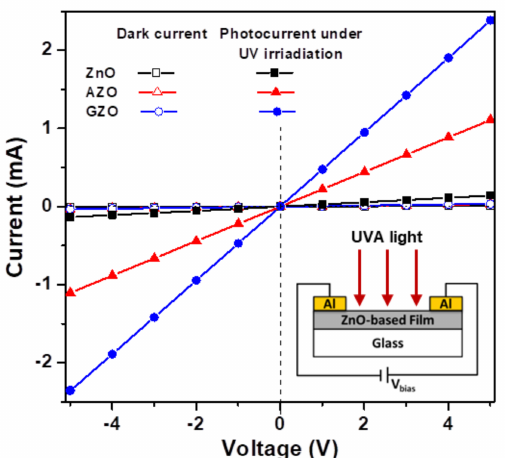
Figure 7. Current-voltage ( I - V ) characteristics of dark and photoilluminated currents under irradiation with UVA light obtained from ZnO-based MSM photodetectors. The inset in the bottom right corner shows the arrangement for I - V measurements.